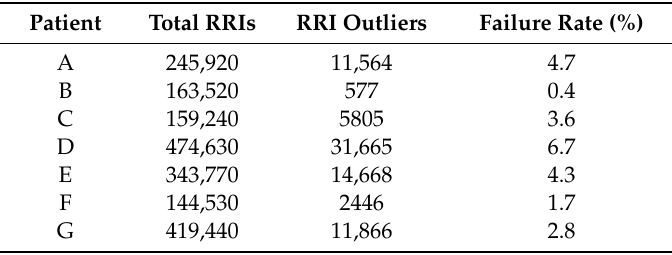
Table 4. Seizure prediction performance. The duration of prediction is shown with the start and the end of exceedance (e.g., − 05:28 to − 05:17) means that the statistic exceeded the control limit from 5 min